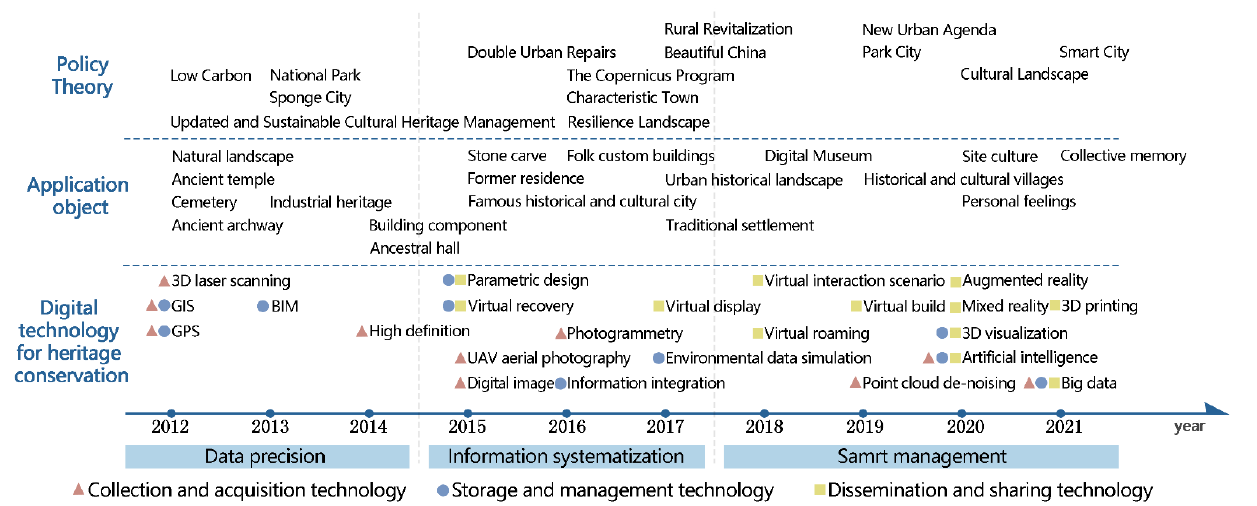
Figure 6. Development trend and evolution mechanism of digital technology for landscape architecture heritage protection over the last 10 years.